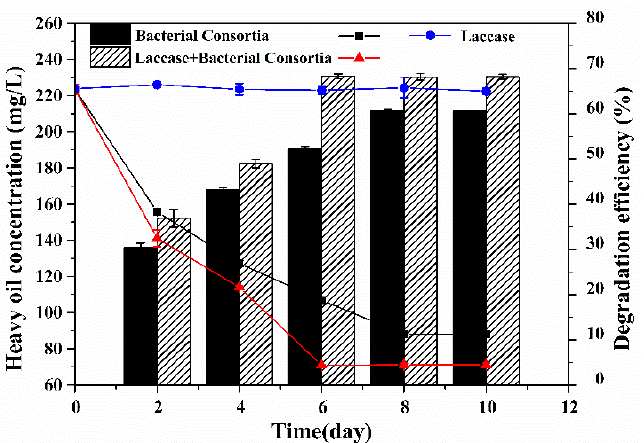
Figure 1. Effect of laccase on heavy oil degradation of bacterial consortia.